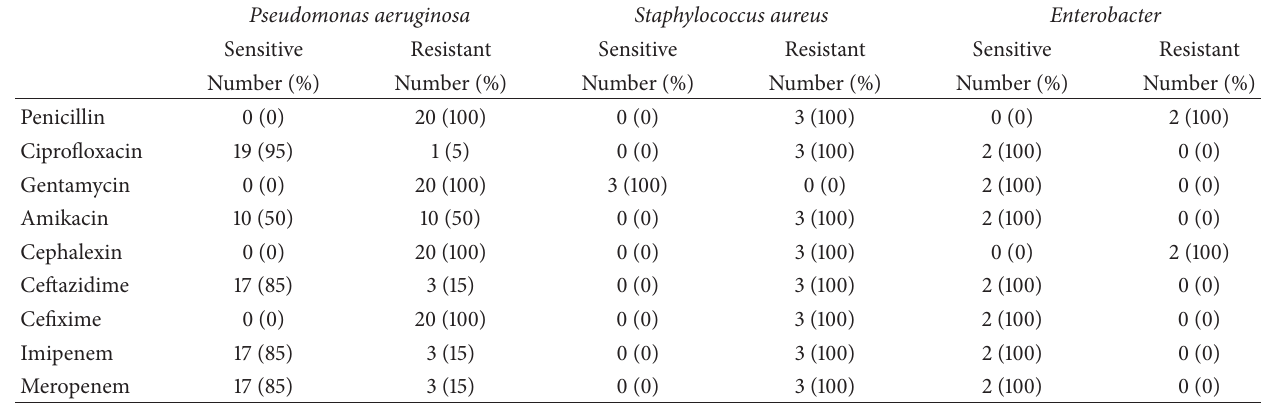
Table 1: Antibiotic sensitivity and resistance pattern of microorganism isolated from corneal ulcers in patients with microbial keratitis.